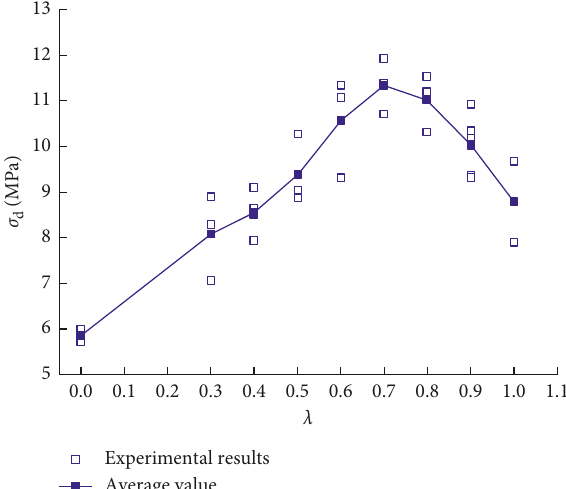
Figure 8: Variation in dynamic compressive strength of artificial frozen silty clay with axial precompressive stress ratio.